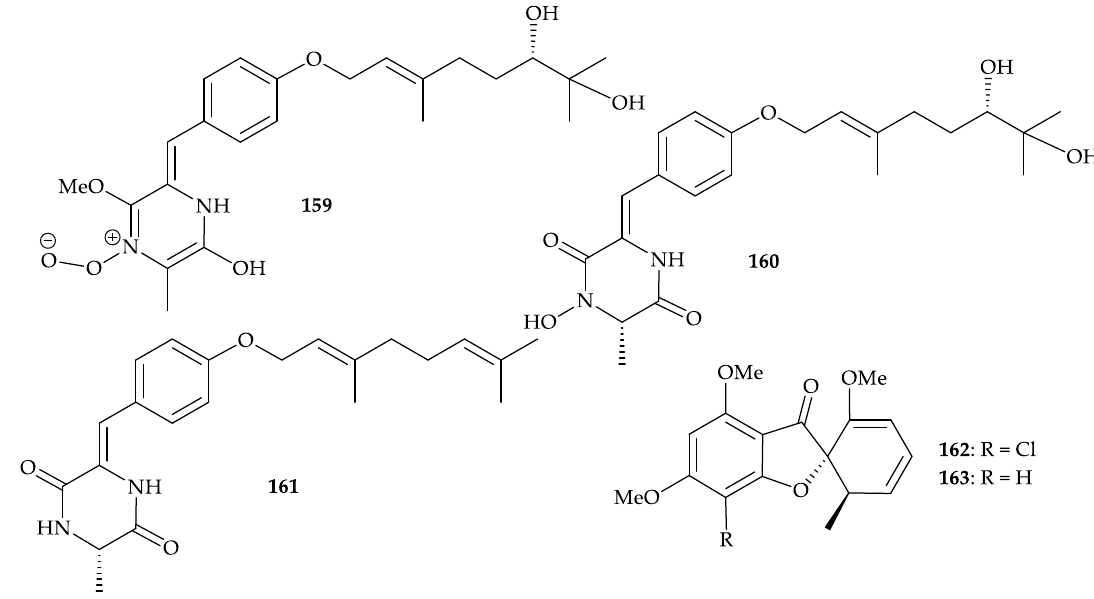
Figure 26. Structures of janthinolides A ( 159 ), B ( 160 ), deoxymycelianamide ( 161 ), griseofulvin ( 162 ), and dechlorogriseofulvin ( 163 ).